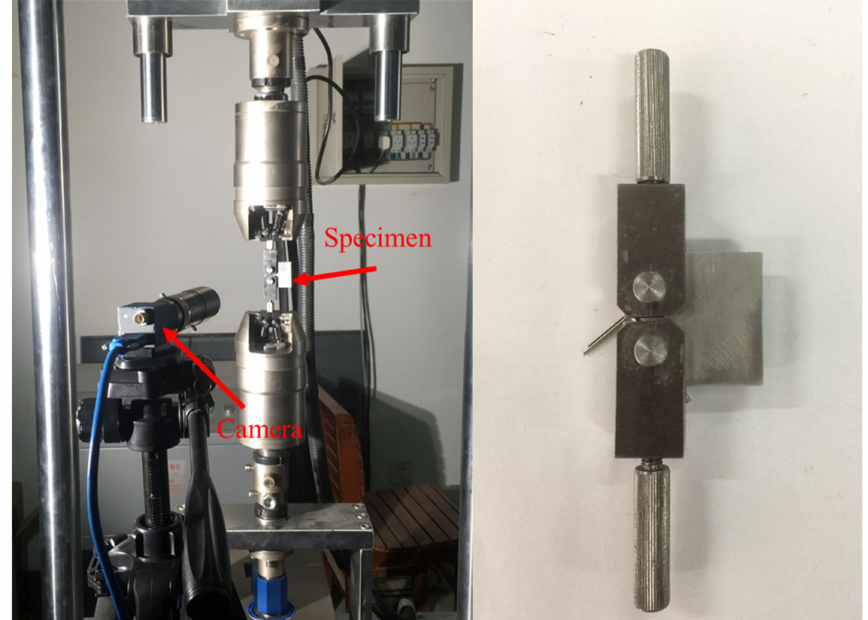
Figure 17. Experimental environment and the CT